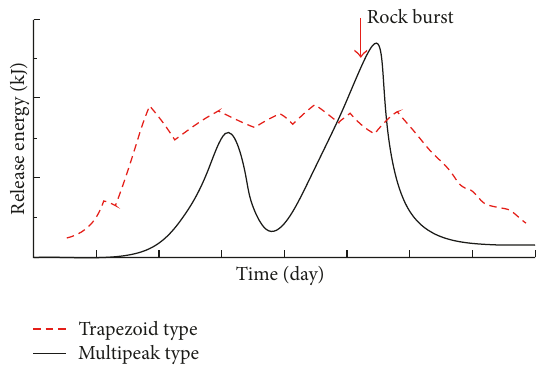
Figure 4: Variation in the microseismic signal during a fault-type rock